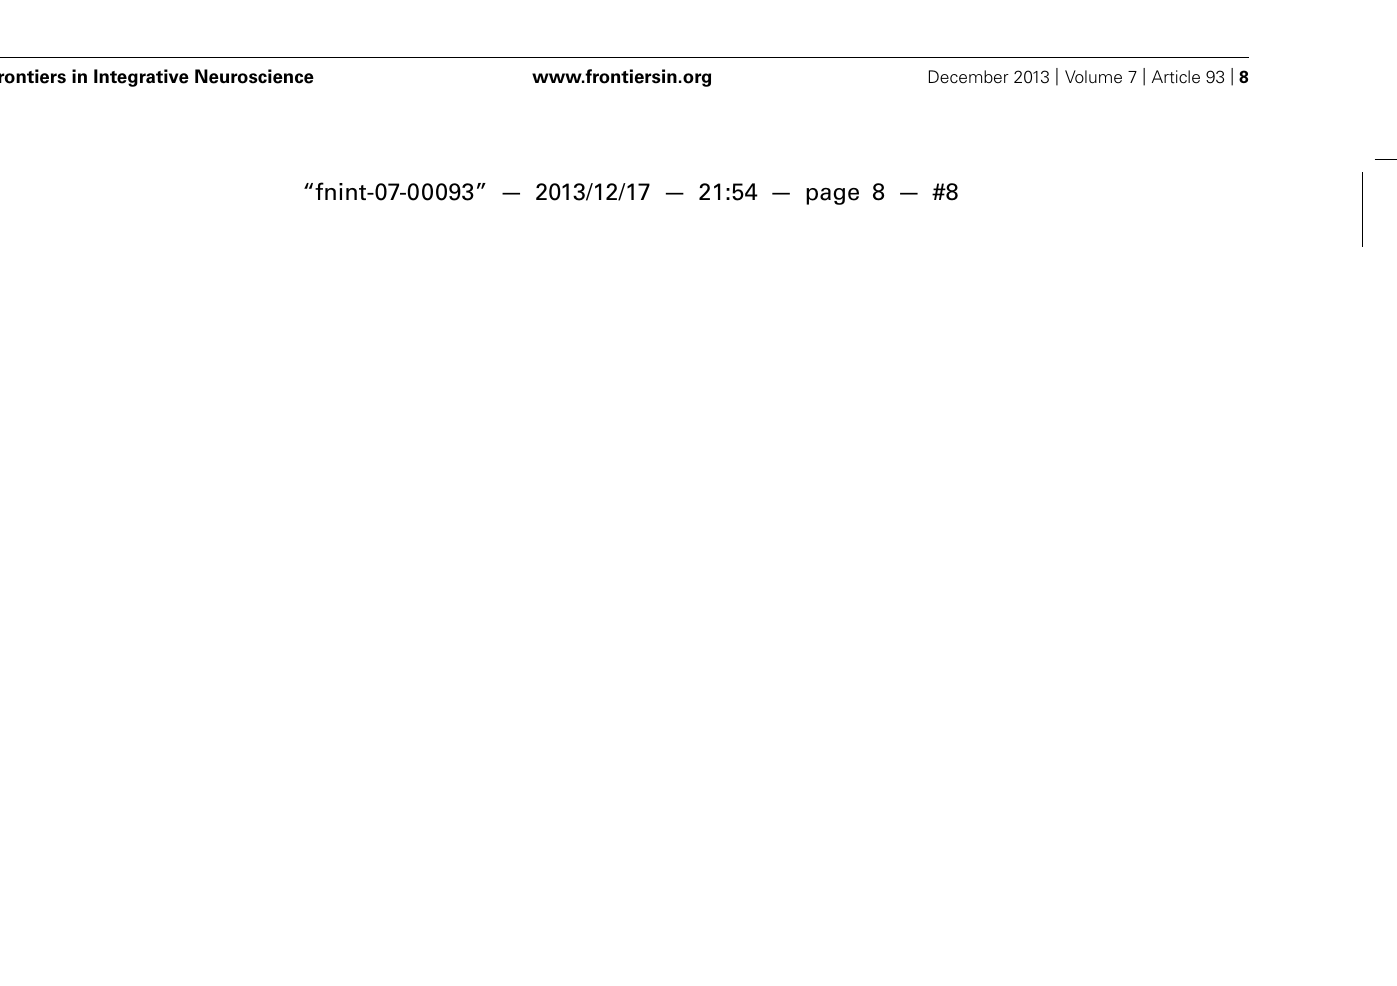
depolarizing step. (B) Averaged data for DSI induced by depolarizing pulses with a duration of 0.5, 1, 3, and 5 s are plotted. (C) No correlation was found between DSI magnitude and size of GABA A IPSC in either sex. (D) Bar graphs summarizing the average paired-pulse ratio (IPSC2/IPSC1) of caudal GABA A IPSCs for all cells recorded in male and female LH rats. No sex dimorphism was found in DSI-induced increased paired-pulsed ratio. (E) In the presence of either AM281 or THL DSI could not be induced in either sex. Data are expressed as mean ± SEM. * P < 0.05, ** P <